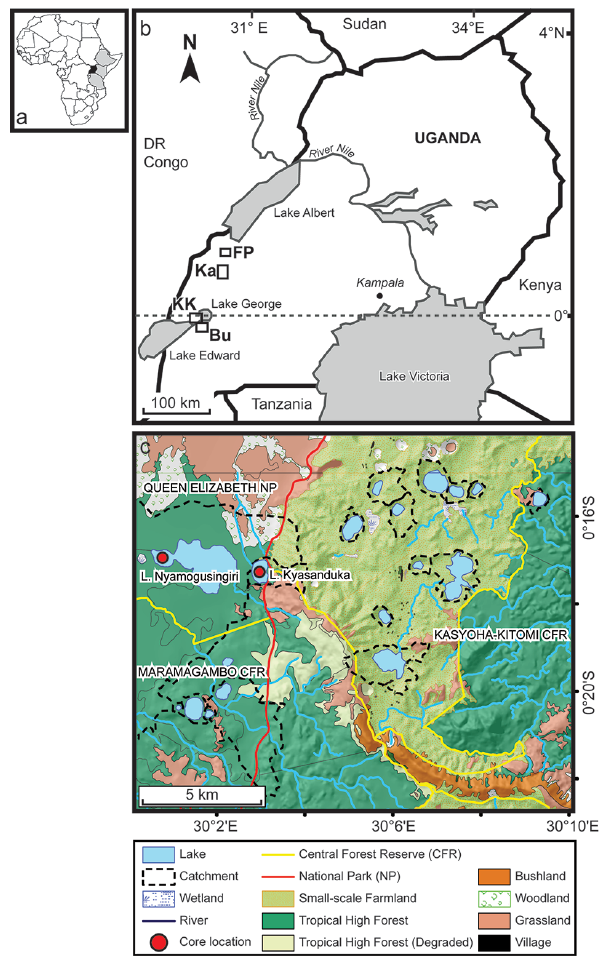
Figure 1. (a) Regional location of Uganda. (b) Map of Uganda showing the four crater lake clusters: Fort Portal (FP), Kasenda (Ka), Katwe-Kikorongo (KK) and Bunyaruguru (Bu), as described by Melack (1978). (c) Bunyaruguru crater lake cluster showing Lake Nyamogusingiri and Lake